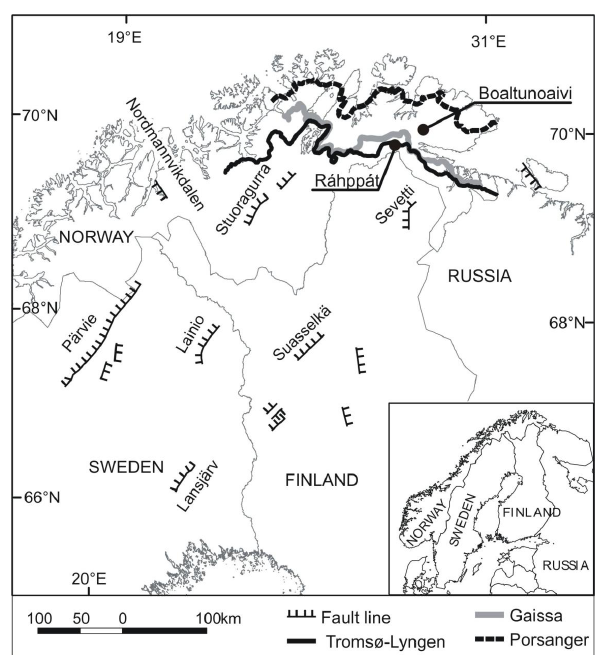
Figure 1. Location map showing major ice-marginal moraines in 702 Finnmark, northern Norway (after Sollid et al., 1973; Olsen et al., 1996). Maskevarri Ráhppát study site and morphologically similar moraine field on Boaltunoaivi fell indicated. The Tromsø-Lyngen moraines were formed ∼ 12.5–12kyBP and the Skarpnes event, possibly correlative to the Porsanger sub-stage, ∼ 14.3–14.1kyBP (Sollid et al., 1973; Vorren and Plassen, 2002). Locations of the northern Fennoscandian postglacial fault lines according to Tanner (1930), Kujansuu (1964), Lundqvist and Lagerbäck (1976), Lager- bäck (1990, 2008), Dehls et al. (2000) and Sutinen et al.